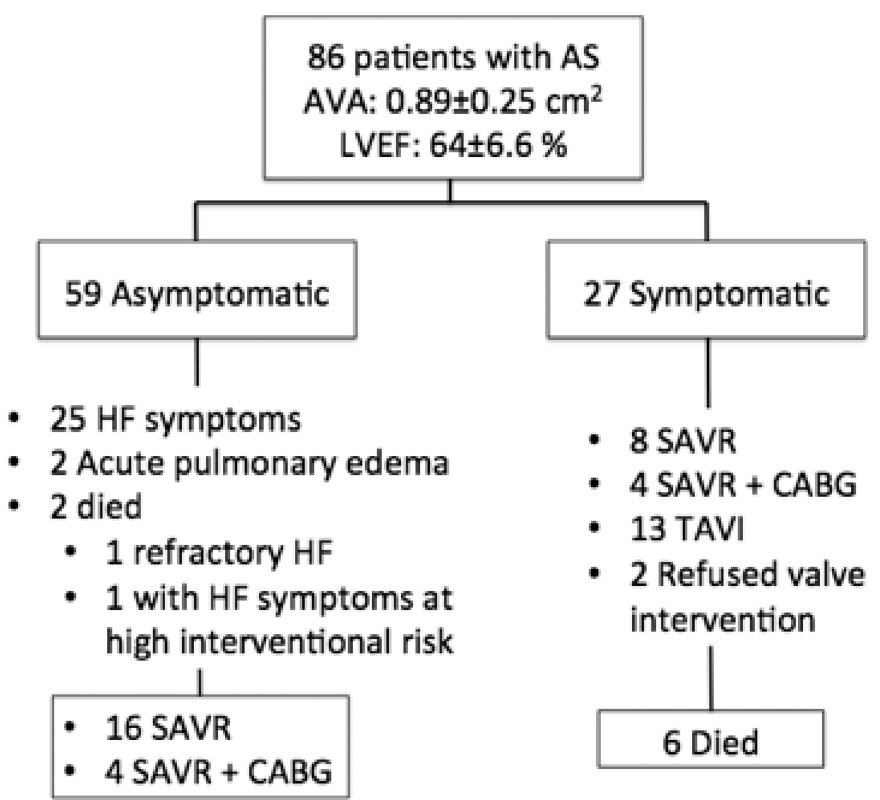
Fig 1. Study population and follow-up. according to gender. BNP was well correlated with age (r = 0.34, p < 0.001), which was also true for sST2 though at a lower extent (r = 0.26, p = 0.02). Both biomarkers increased with the symptomatic status (BNP: 100±122 vs. 270±322 pg/mL; sST2: 21±8 vs. 27±11 ng/mL; p < 0.001 for all) and the NYHA class (BNP: NYHA class I 100±122, class II 141±125, class III-IV 358 ±256 pg/mL; sST2: NYHA class I 18±4, class II 20±8, class III-IV 33±9 ng/mL; p < 0.001 for class I/II vs. III-IV) (Fig 2). Risk score and BNP ratio were also higher in symptomatic patients (p < 0.05). In multivariable logistic regression analysis, after adjustment for age, severity of AS, BNP, left atrial size, E/e ’ , and LV mass, independent determinants of symptoms were sST2 (odds-ratio [OR] = 1.1, 95% confidence interval [CI] = 1.0 – 1.3; p = 0.037) and mitral E/e ’ (OR = 1.35, CI = 1.02 – 1.8; p = 0.025). Similar results were obtained when BNP ratio was used instead of age and BNP (sST2: OR 1.07, CI = 1.008 – 1.15; p = 0.028; E/e ’ : OR 1.22, CI = 1.07 – 1.40; p = 0.0036). Using ROC curve analysis, the best cut-off value to identify symptomatic patients was 23 ng/mL for sST2 (AUC = 0.68, sensitivity = 60%, specificity = 74%, p < 0.01). In the overall population, plasma levels of BNP and sST2 were correlated with the severity of AS, the degree of LV hypertrophy, the diastolic burden (left atrial area, E/e ’ ) and with the LV ejection fraction (Table 2). sST2 levels were also modestly correlated with BNP levels (r = 0.4, p < 0.01) (Fig 3). With multiple linear regression analysis, left atrial index (p < 0.0001) and aor- tic valve area (p = 0.004; model R 2 = 0.32) were correlated with sST2 levels. Left atrial index (p = 0.025) and E/e ’ (p = 0.03; model R 2 = 0.29) were determinants of BNP. In asymptomatic patients, mean aortic pressure gradient and E/e ’ were correlated with BNP, whereas aortic valve area, LV mass, and left atrial size were correlated with sST2. E/e ’ (p < 0.001; model R 2 =